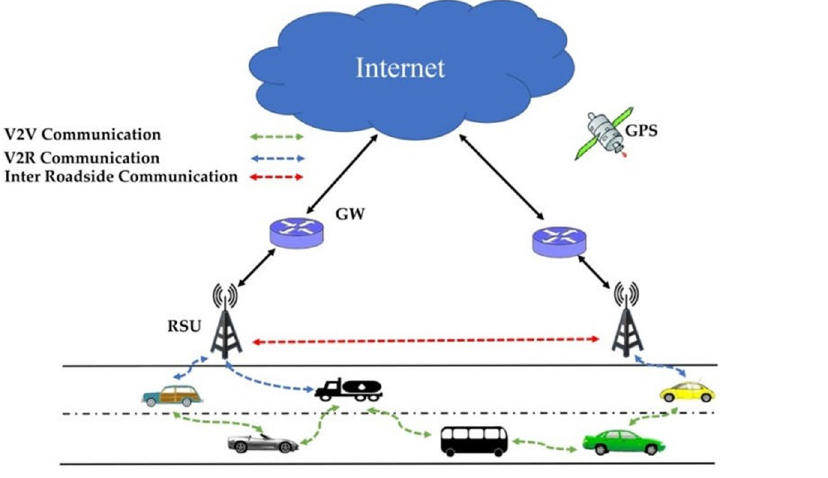
Fig 1. Vehicular ad hoc networks